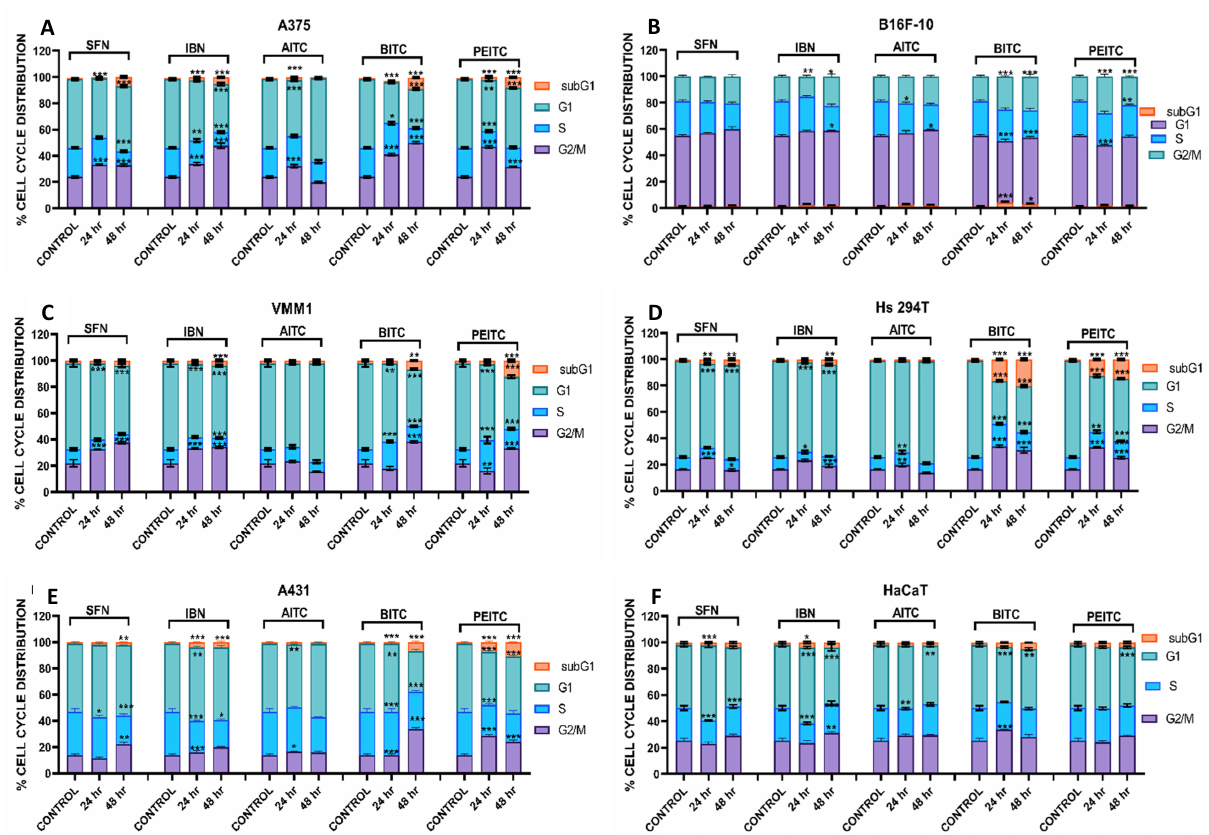
Figure 4. The effect of various ITCs on cell cycle progression in an in vitro model of MM. Cells were exposed to 10 µ M of each ITC, for 24 and 48 hr, and monitored by means of flow cytometry. Results were quantified as percent of total DNA content accumulated at each phase of the cell cycle (e.g., sub-G1, G1, S and G2/M) for ( A ) A375, ( B ) B16F-10, ( C ) VMM1, ( D ) Hs294T, ( E ) A431 and ( F ) HaCaT cells. Data shown are means ± SD of three replicates from three independent experiments. * p < 0.05, ** p < 0.01, *** p < 0.001, when compared to untreated (control)